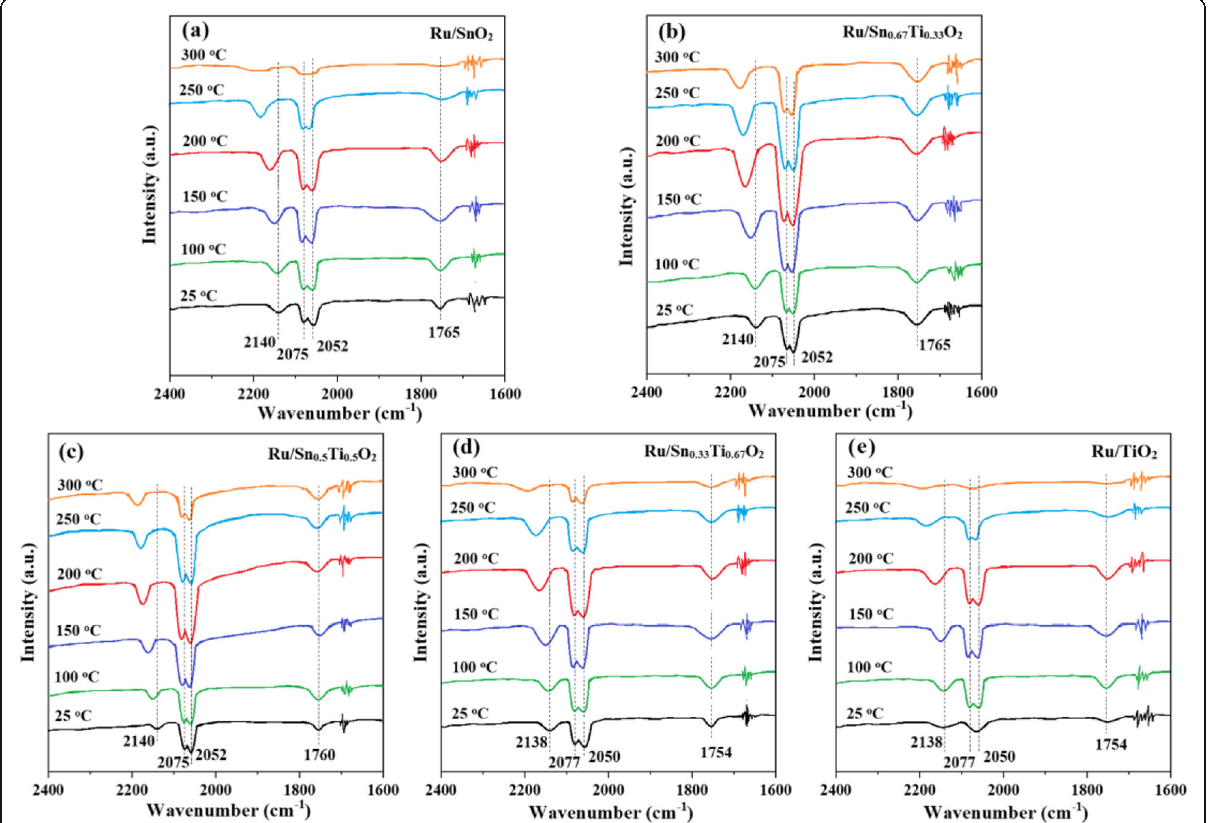
Fig. 11 In situ FI-IR spectra of the 10% CO/Ar interaction with a Ru/SnO 2 , b Ru/Sn 0.67 Ti 0.33 O 2 , c Ru/Sn 0.5 Ti 0.5 O 2 , d Ru/Sn 0.33 Ti 0.67 O 2 , e Ru/TiO 2 at different